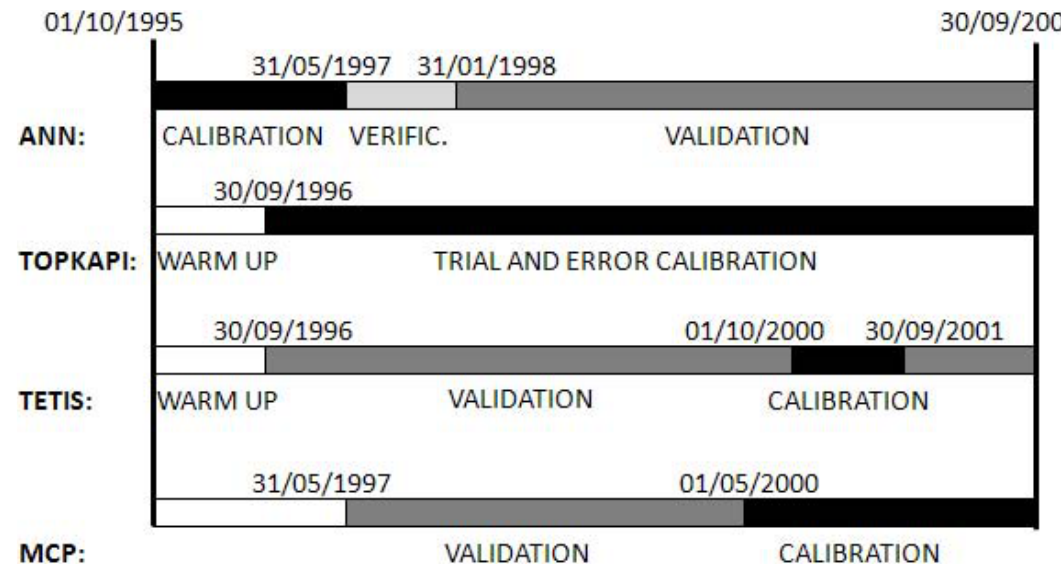
Fig. 10. Schematization of the available data division for calibrating and validating the models and the MCP.